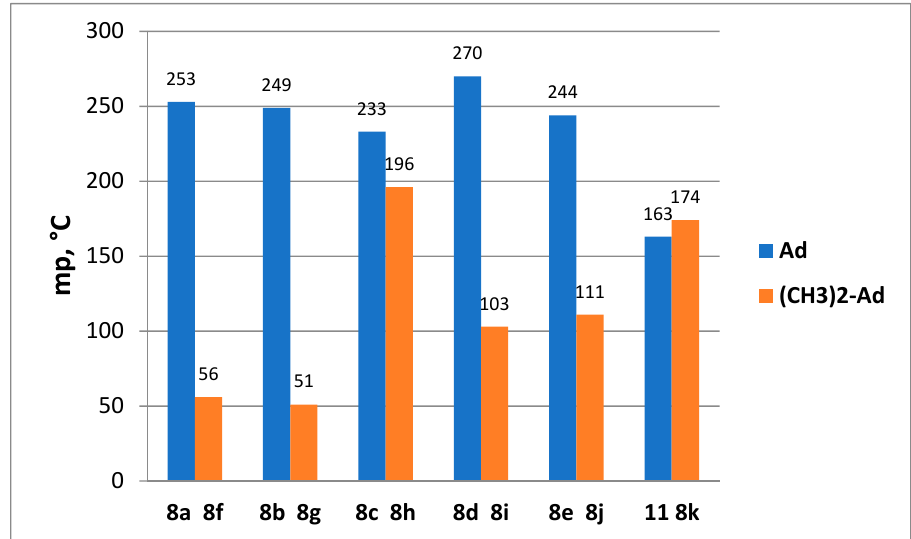
Figure 1. Comparison of the melting temperatures of urea products based on 1-[isocyanato (phenyl)methyl] adamantane 5a and obtained on the basis of 1-[isocyanato (phenyl)methyl]-3,5- dimethyladamantane 5b